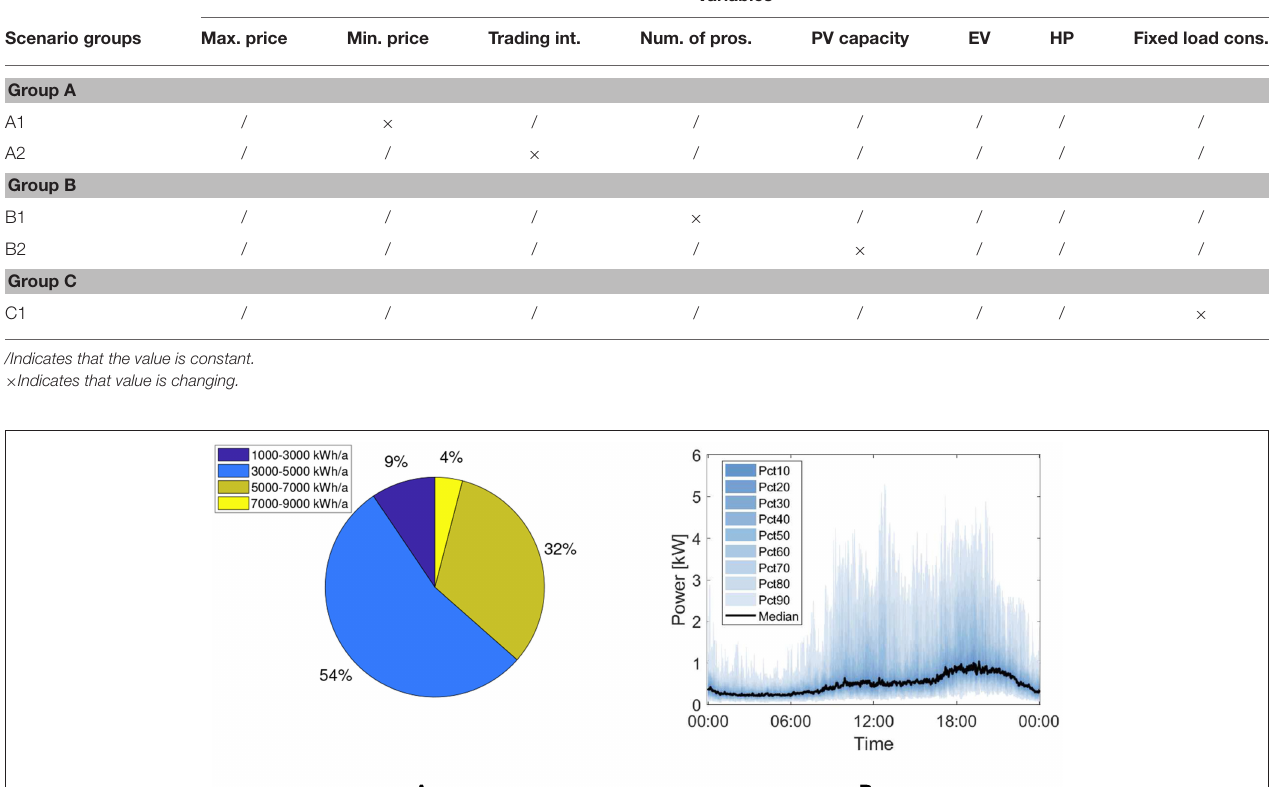
TABLE 1 | Input parameters of the scenario groups. Scenario